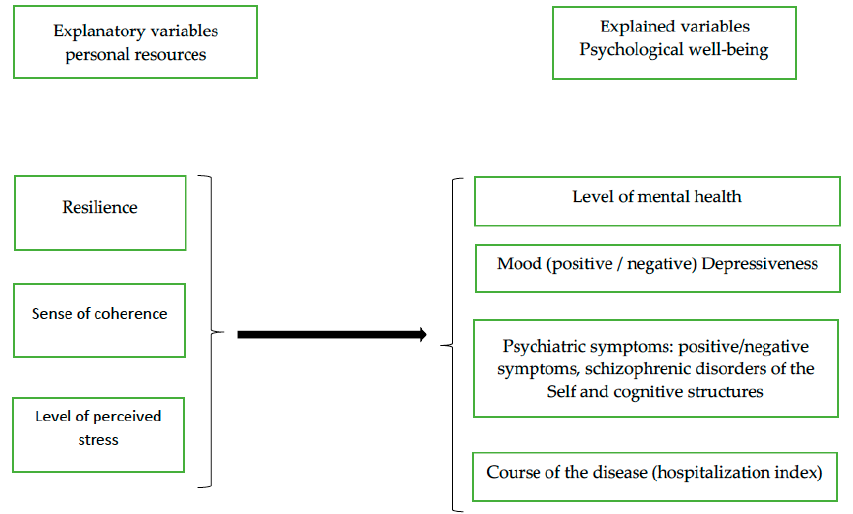
Figure 1. The research model: Personal resources as potential predictors of psychological well-being in patients with schizophrenia (own